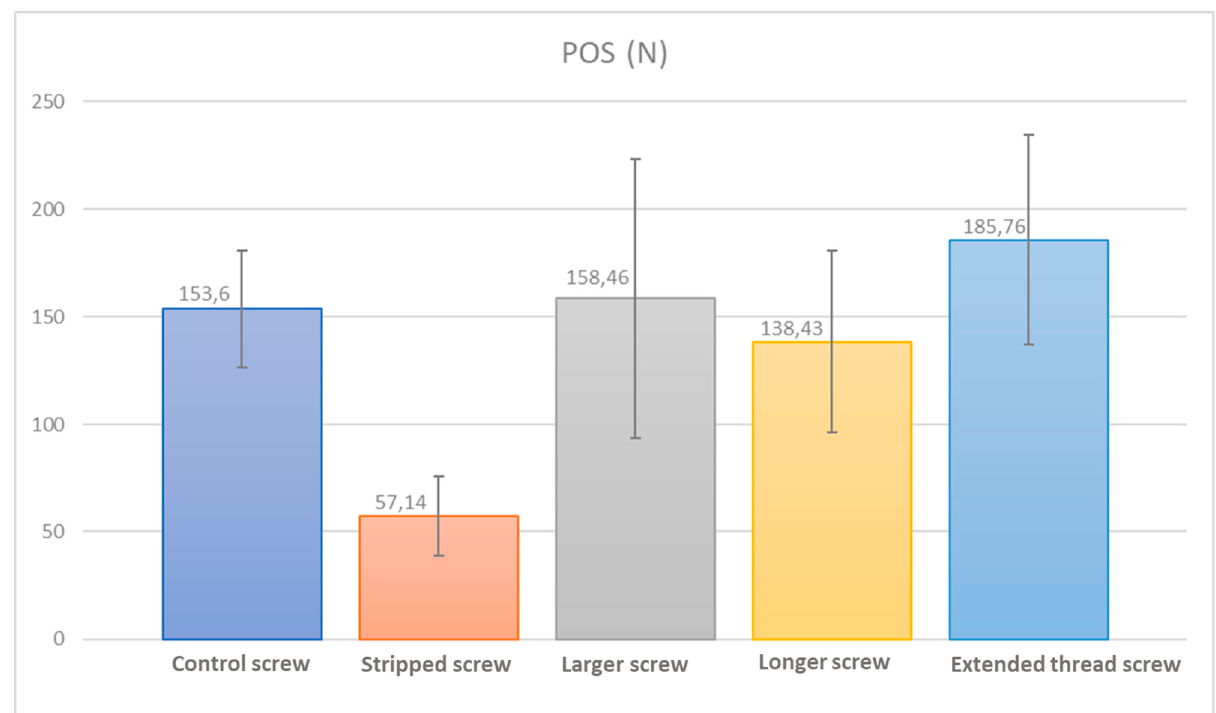
Figure 5. Experimentally obtained pull-out strength values for the considered configurations.